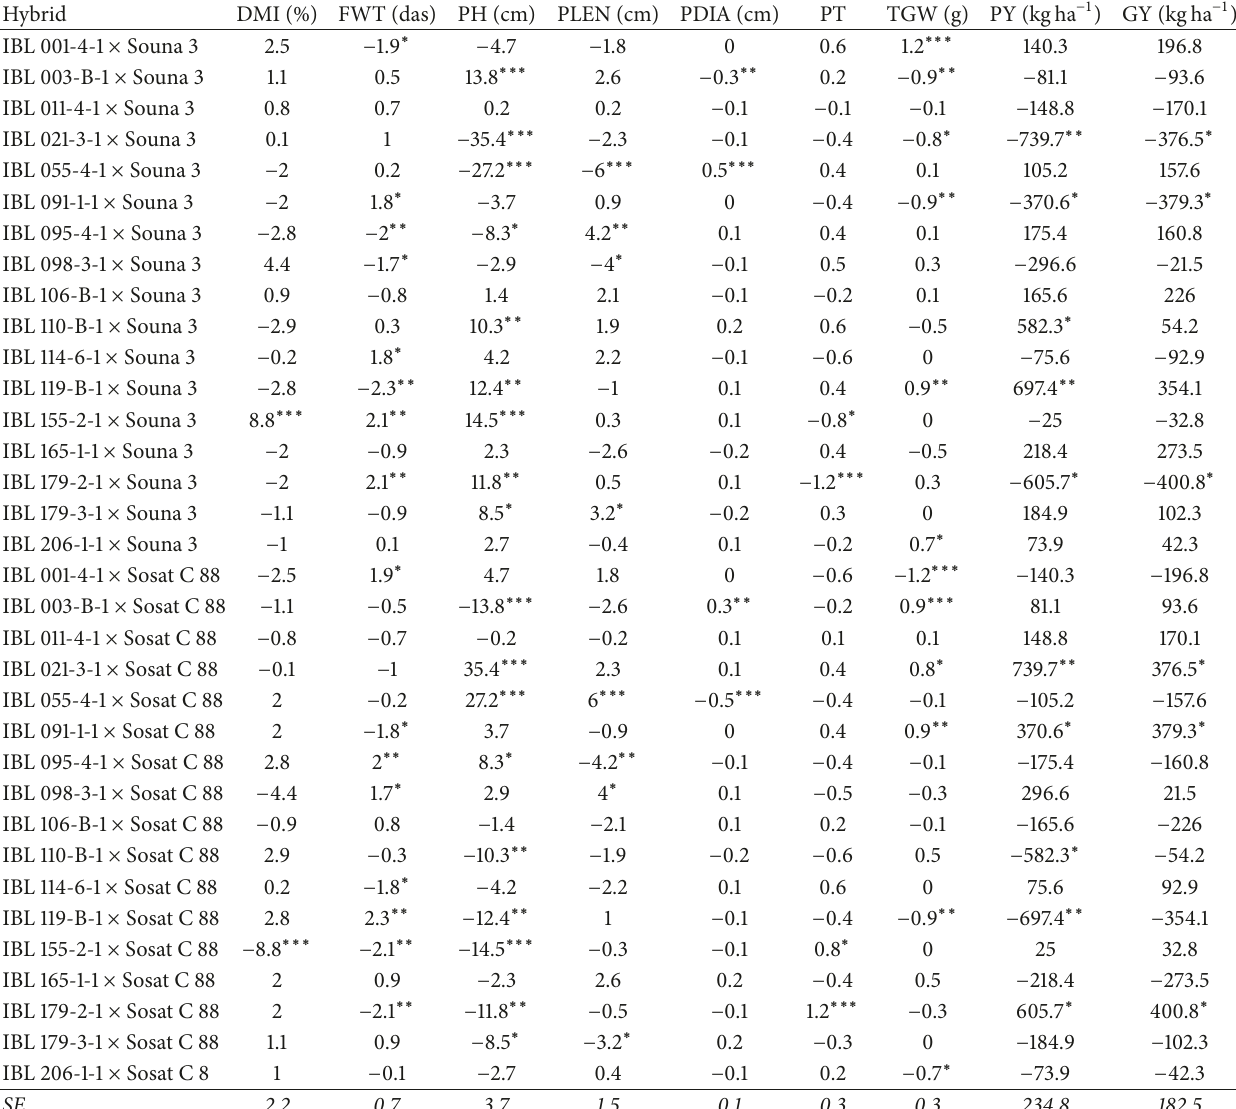
Table 7: Estimates of SCA effects for hybrids evaluated across the two